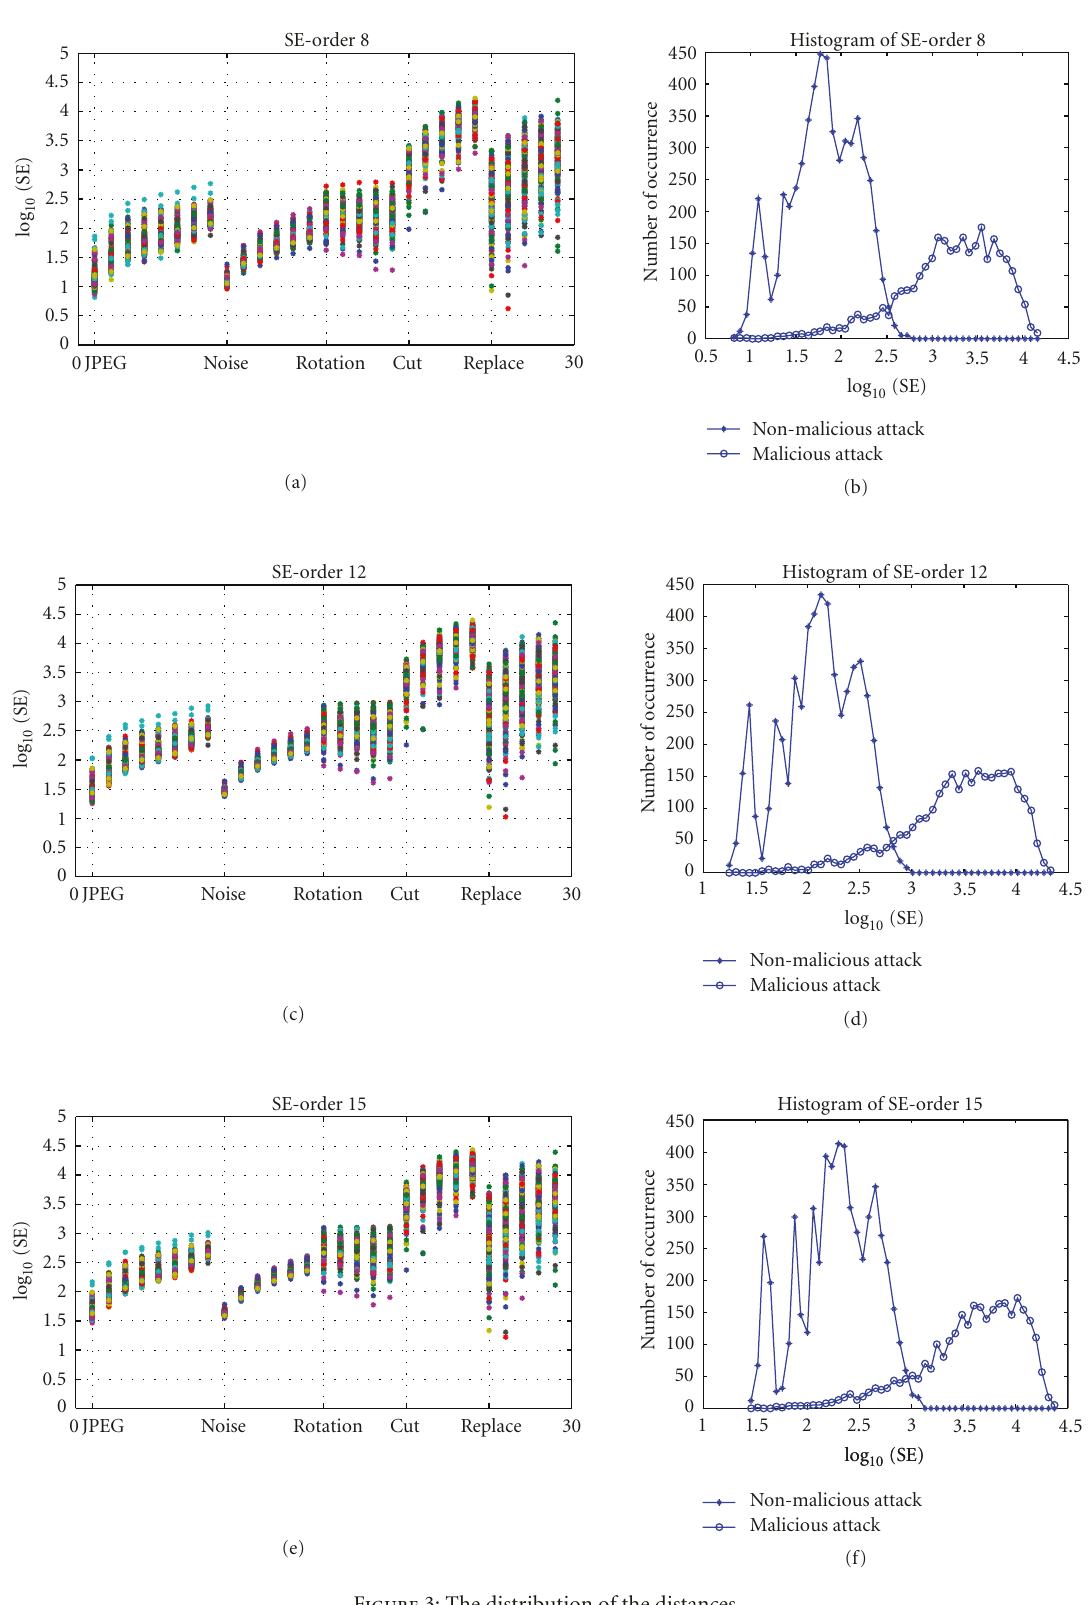
Figure 3: The distribution of the